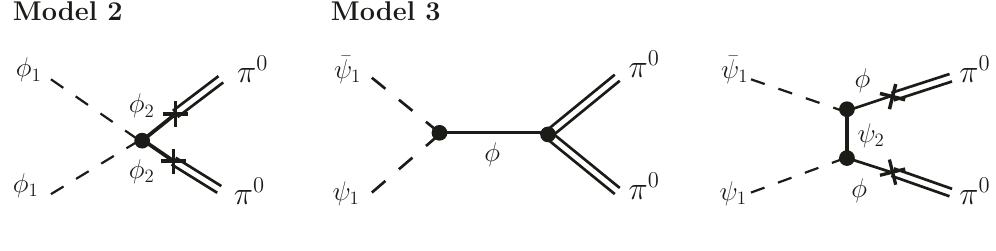
(cid:25) 0 (cid:25) 0 and 1 (cid:22) 1 (cid:25) 0 (cid:25) 0 ! !